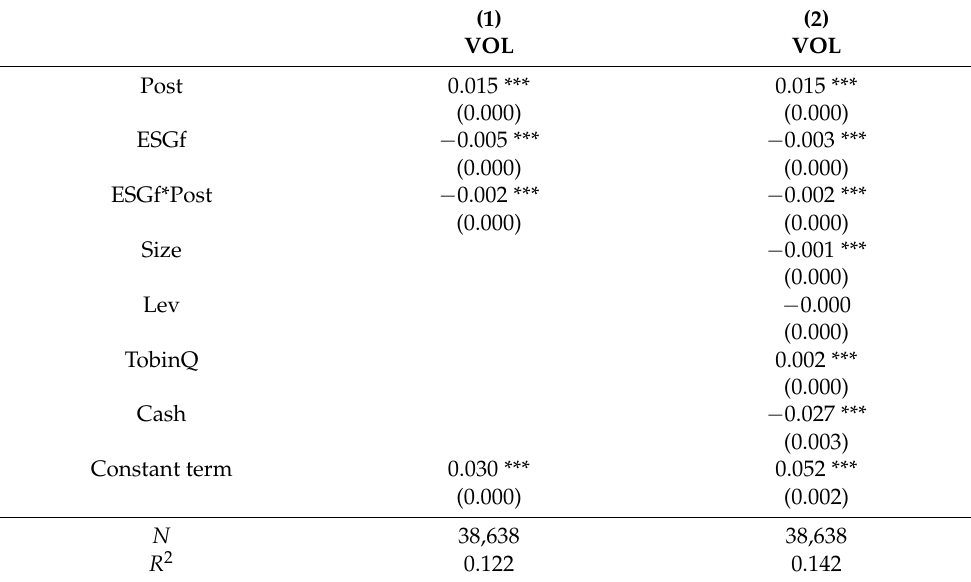
Table 7. Change the time